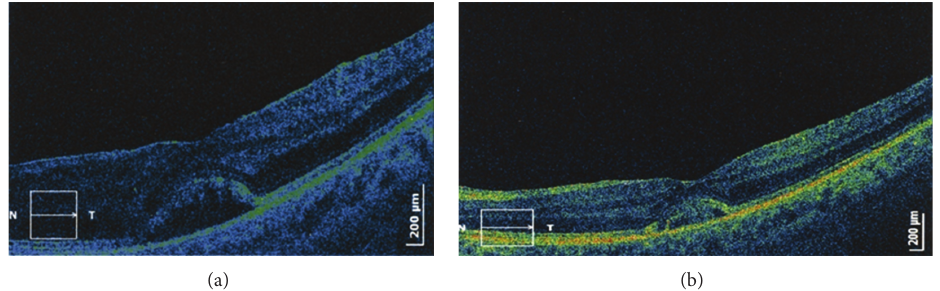
Figure 5: (a) and (b) Behcet’s disease, OCT monitoring of macular edema in retinal